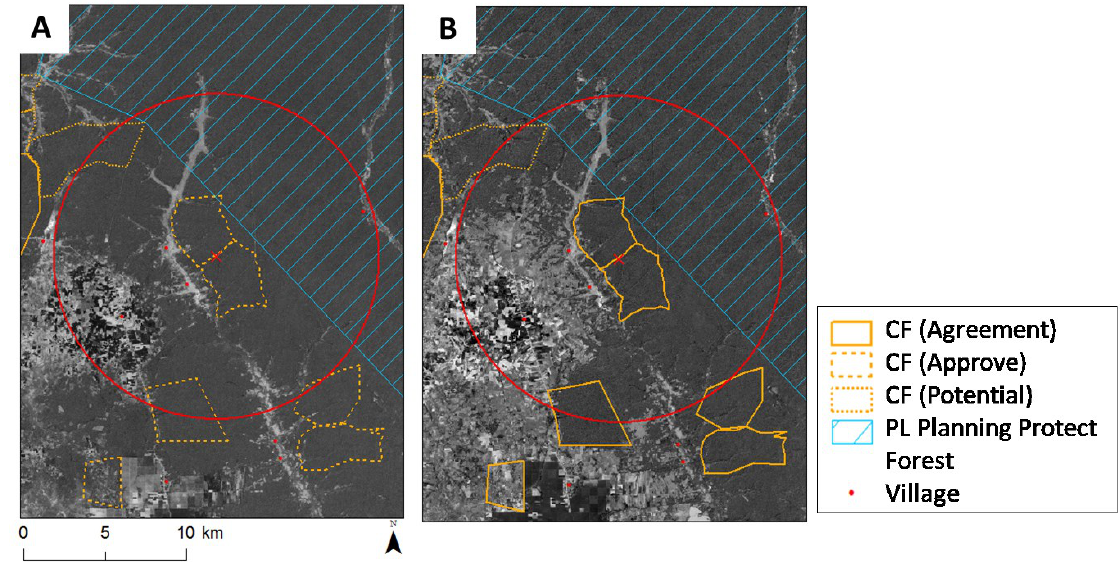
Figure 4. Recent changes in land cover and community forestry (CF) site status in an area with little deforestation within CF sites. Source: NDVI of ( A ) Landsat 5 TM taken on 14 January 2009 and ( B ) Landsat 7 taken on 11 January 2014. CF statuses for ( A , B ) were available from the Kampong Thom provincial office of the Forestry Administration and are based on the periods of June 2010 and September 2014, respectively.